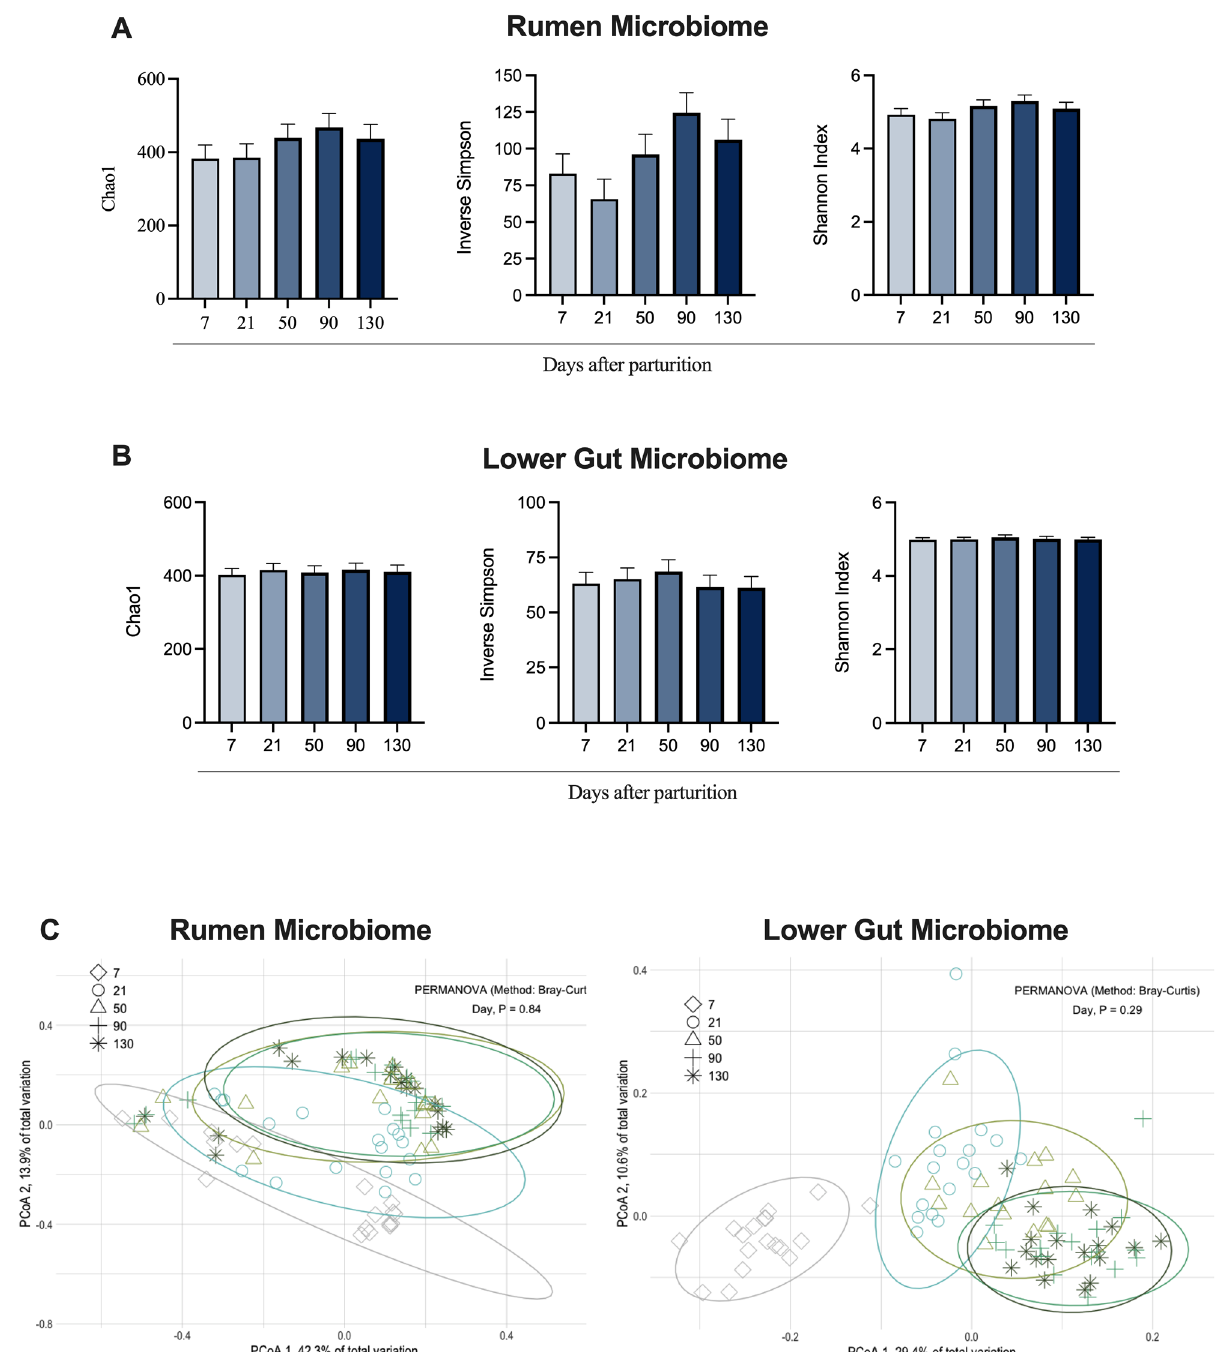
Figure 1. Effects of the day of lactation on alpha- (Chao, Inverse Simpson, and Shannon) and beta-diversity indexes from the rumen and lower gut microbiomes in first lactation Holstein cows. Permutational multivariate analysis of variance (PERMANOVA) was calculated using the Bray–Curtis method and used to test dispersion centroids in the principal coordinate analysis (PCoA). Significance was declared at P ≤ 0.05; however, no significant differences were observed for any diversity